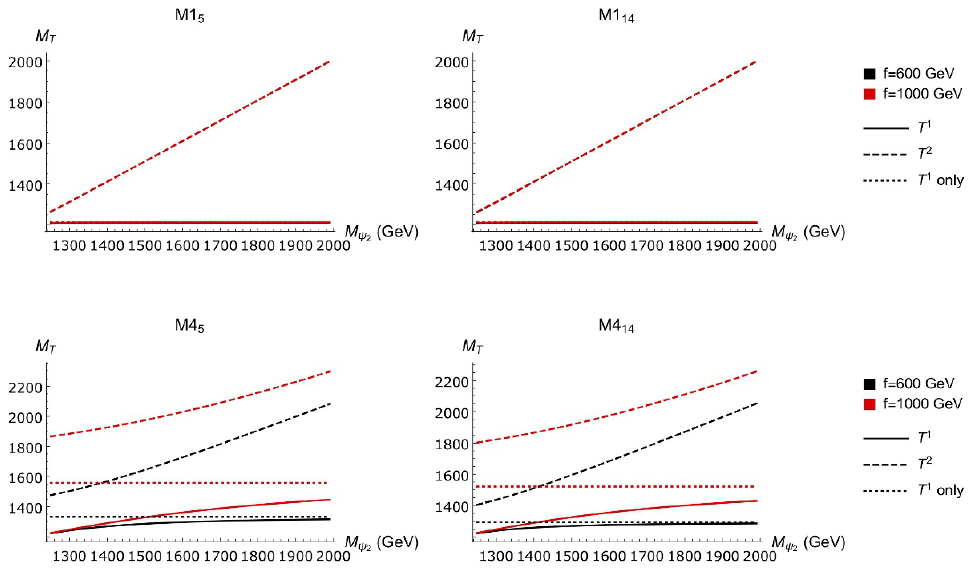
Figure 1 . The masses of the two light top-partners T 1 or T 2 as functions of the heavier vector-like mass, for M (cid:9) = 1200 GeV, y = 1, and f = 600 = 1000 1